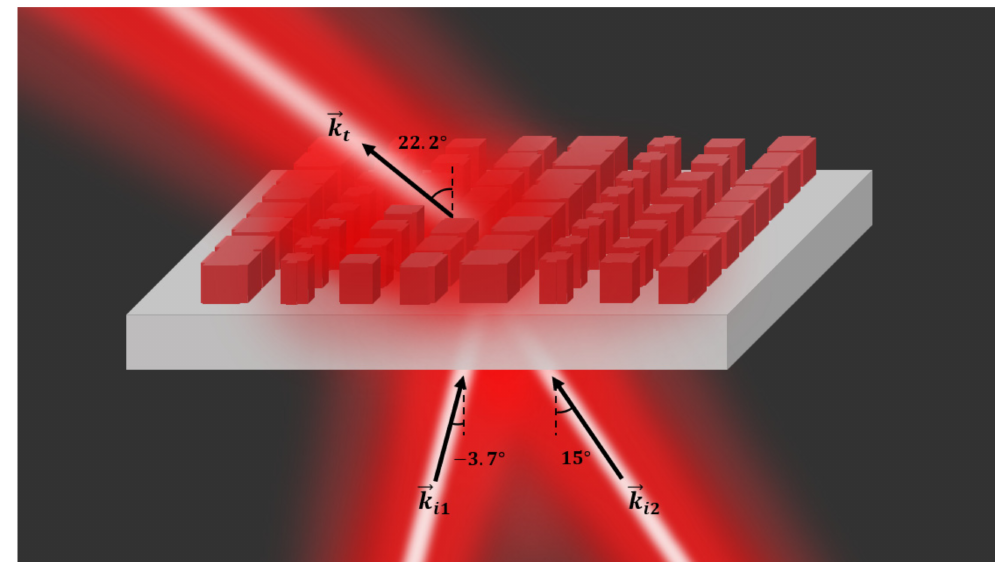
Figure 1. Schematic depiction of our metasurface combiner. Two incident beams will be bent to the same diffraction angle after propagating through the metasurface. The incident angles are − 3.7 ◦ and 15 ◦ , respectively. The diffraction angle is 22.2 ◦